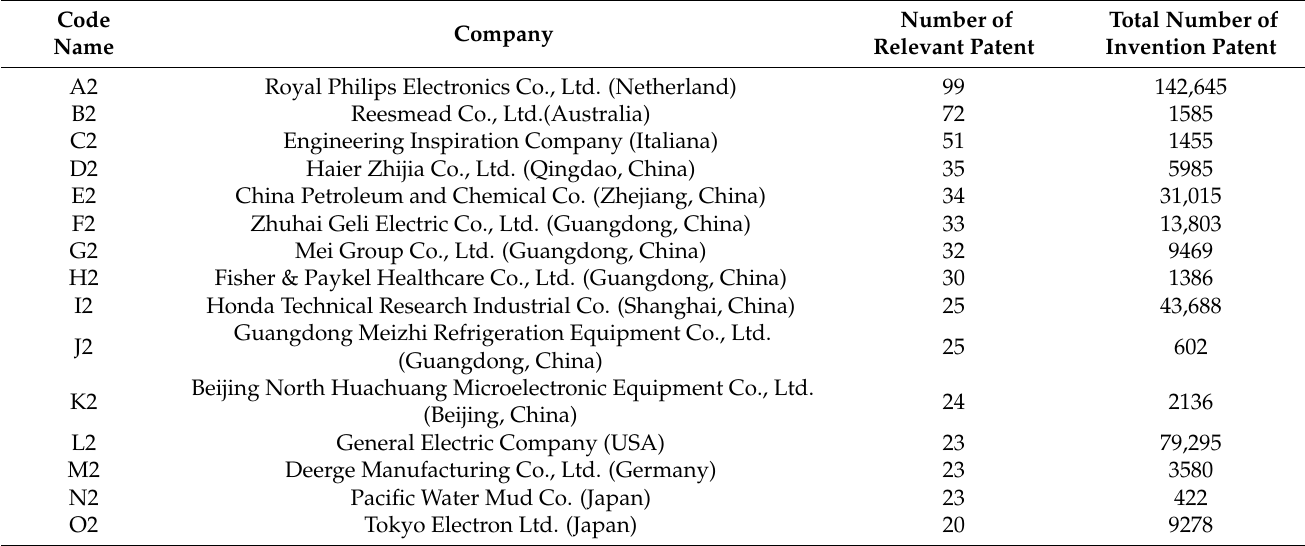
Table A4. Patents of the 15 companies (vacuum